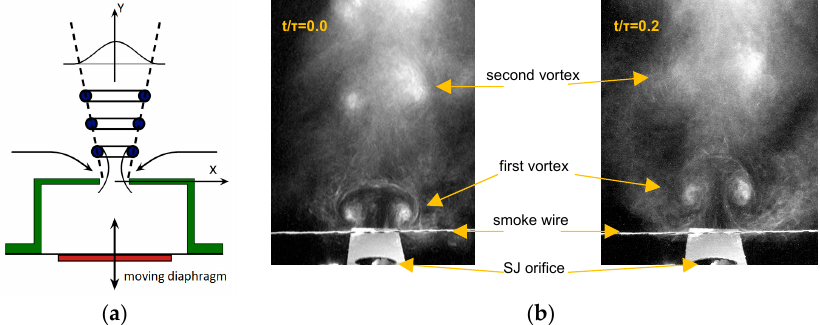
Figure 1. ( a ) Schematic view of the synthetic jet, ( b ) SJ vortex visualization by smoke wire (experiment by Dancova in [36]).